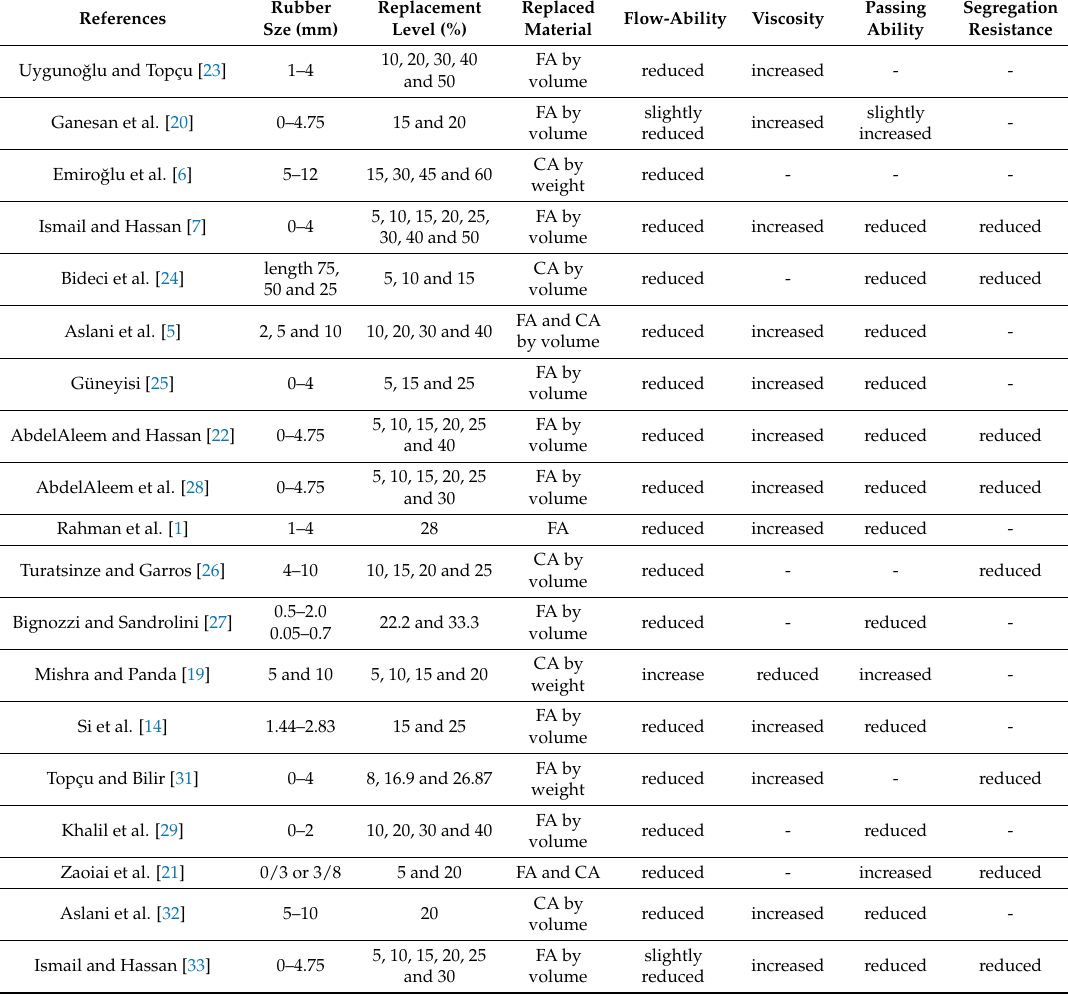
Table 1. Flowability, viscosity, passing ability, and segregation resistance of self-compacting concrete with increasing of rubber aggregate